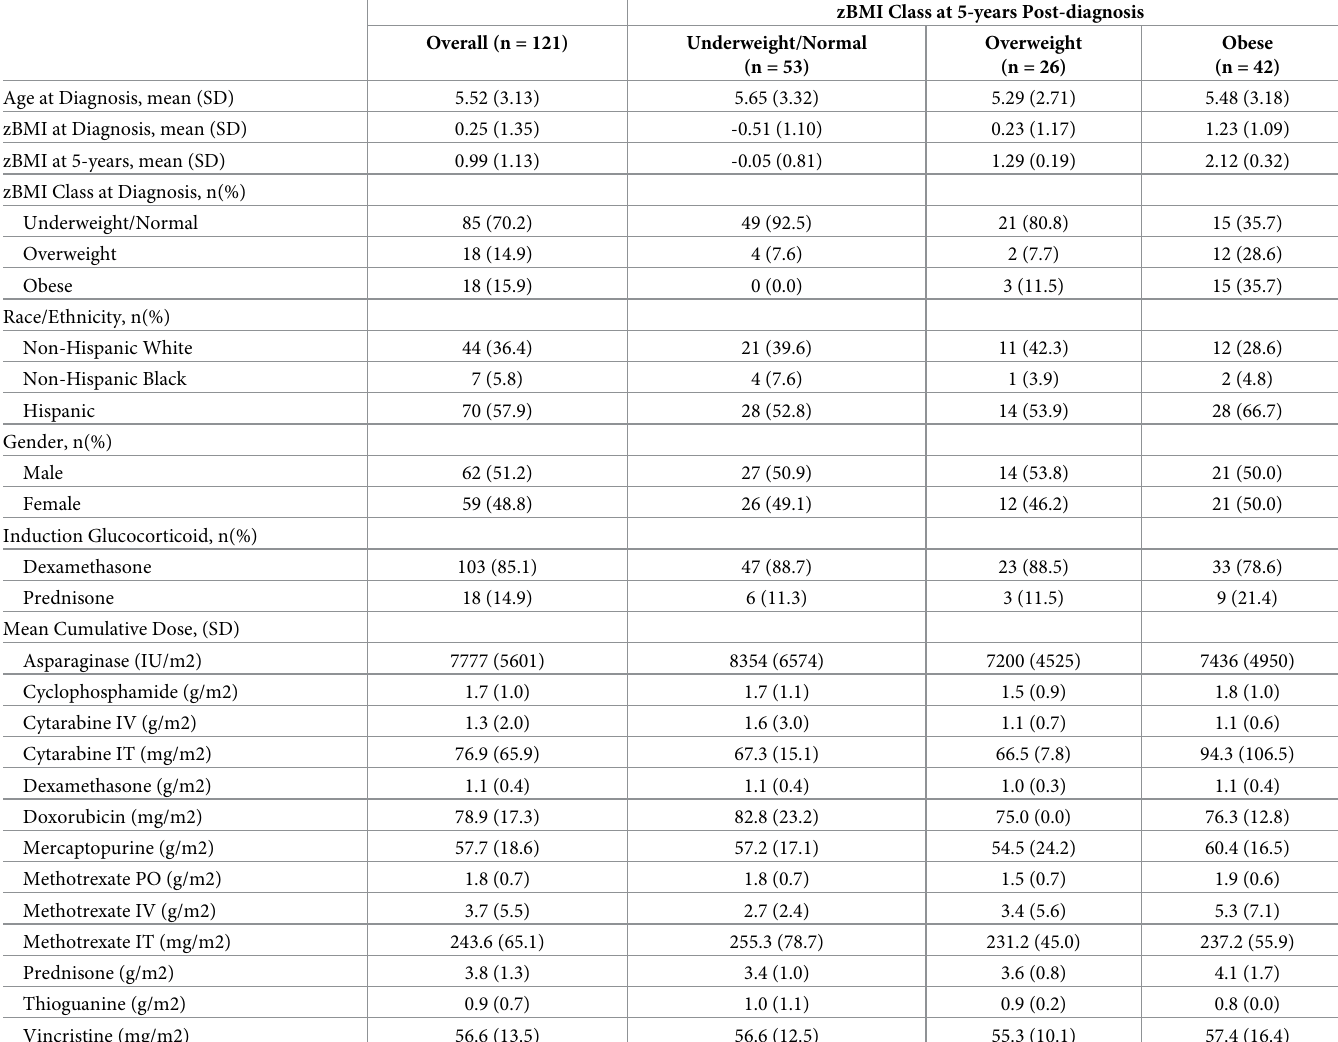
Table 1. Demographic and clinical characteristics of pediatric ALL